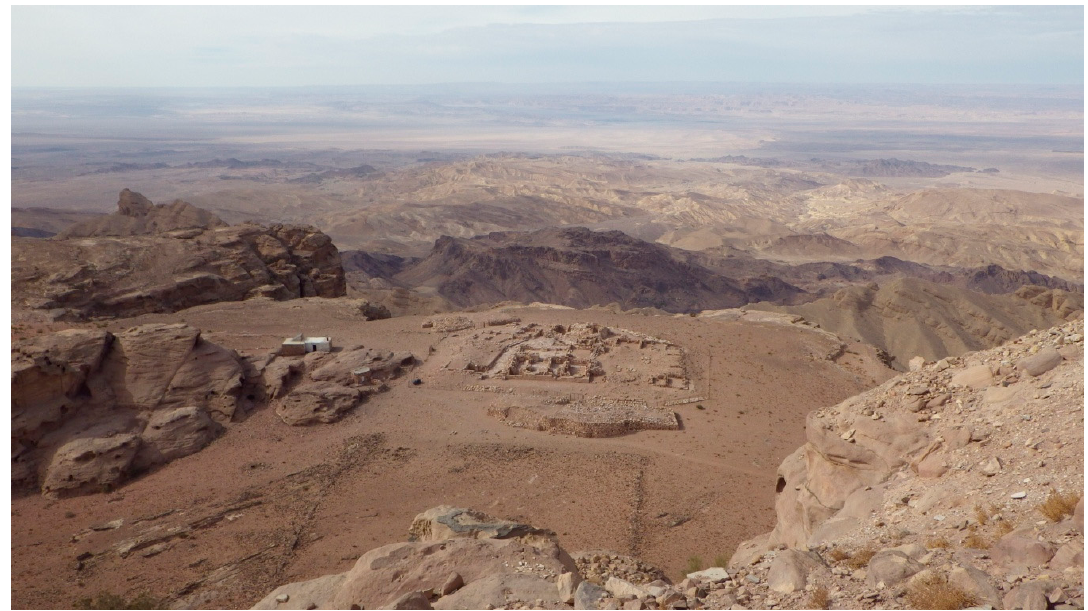
Figure 2. View south from the sampled ruin near the central wadi at Horvat Haluquim, showing the surrounding landscape in the Negev.